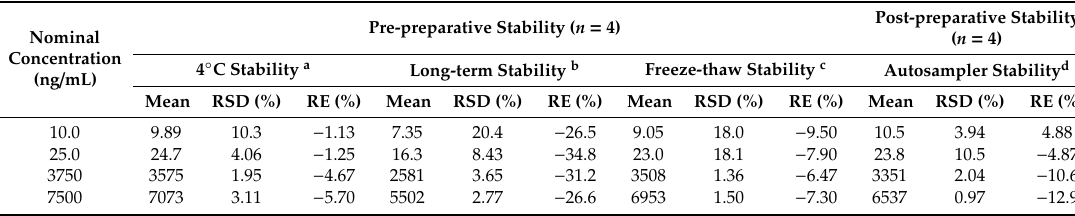
Table 3. Pre- and post-preparative stability of ECN.